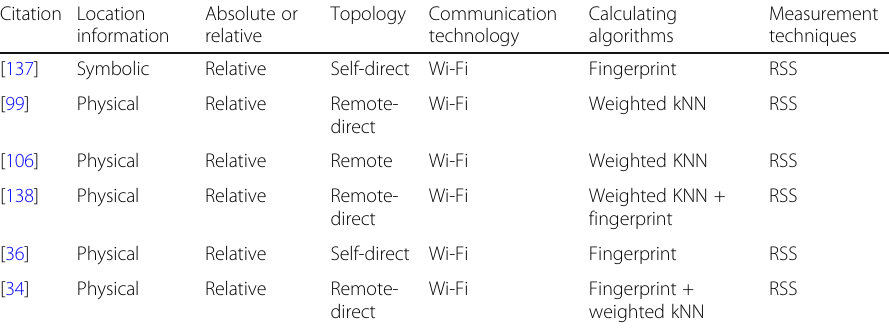
Table 5 The positioning metrics (Continued) Citation Location